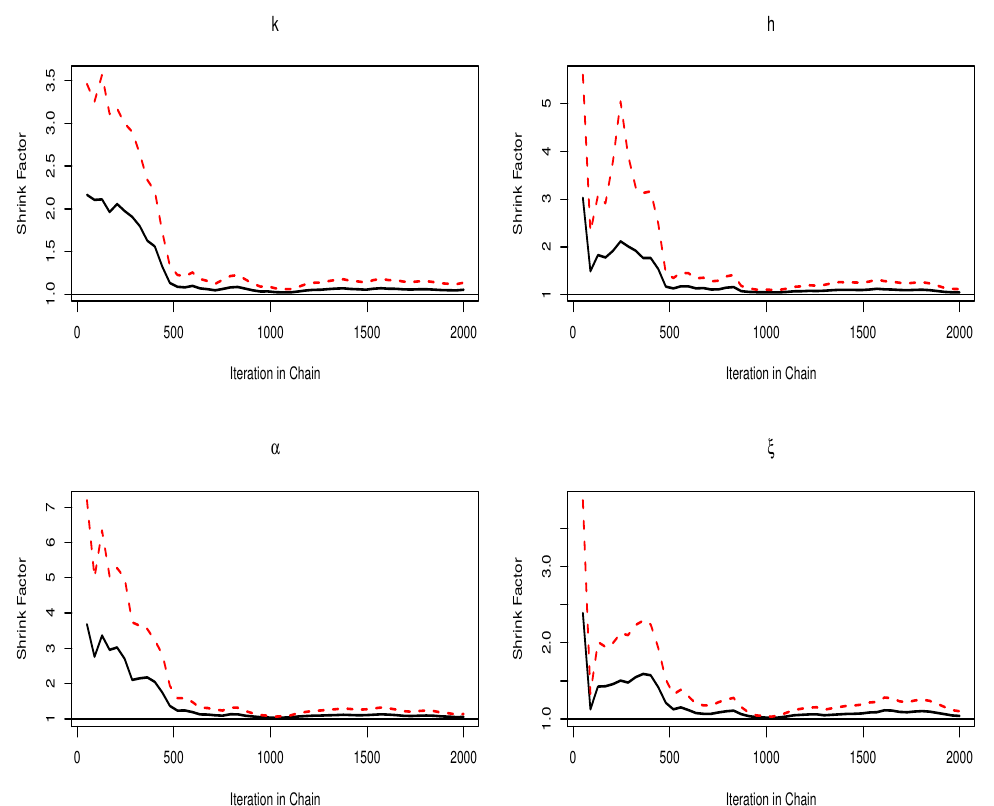
Figure 11. The trace plots of the estimated potential scale reduction factors (solid line) and the upper bounds (dashed line) of its 95% confidence intervals by iterations in the Markov chains for each parameter from the annual maximum wind speed data at Udon Thani,